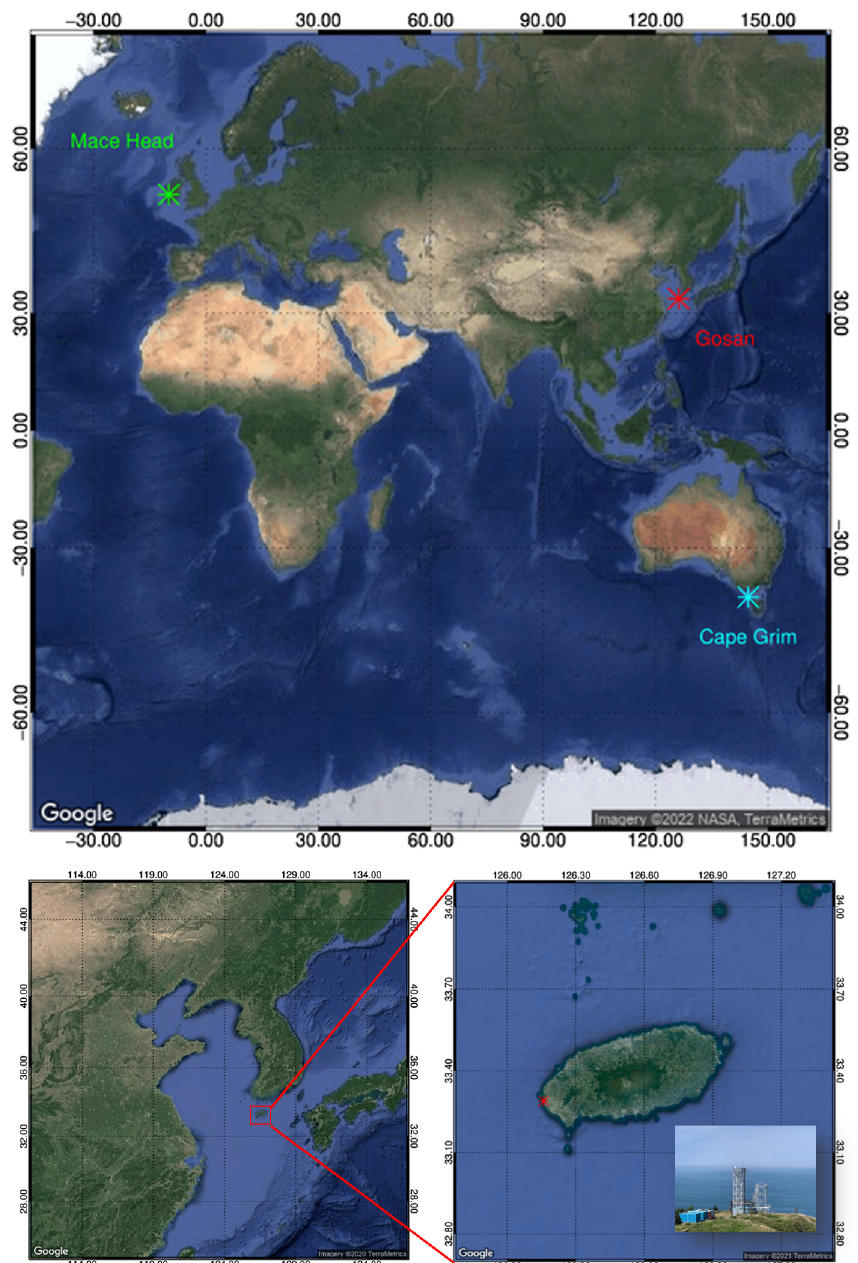
Figure 1. Gosan station (33.3 ◦ N, 126.9 ◦ E; 72ma.s.l.) on Jeju Island, South Korea (red asterisk). Air samples are taken at 17m ( ∼ 100ma.s.l.) from a tower next to the coastal cliff. The geographic locations of Ireland’s Mace Head (53.3 ◦ N, 9.9 ◦ W) and Australia’s Cape Grim (40.7 ◦ S, 144.7 ◦ E), representing the remote background monitoring stations in the Northern Hemisphere and Southern Hemi- sphere, are indicated by green and blue asterisks, respectively. (Map data: © Google